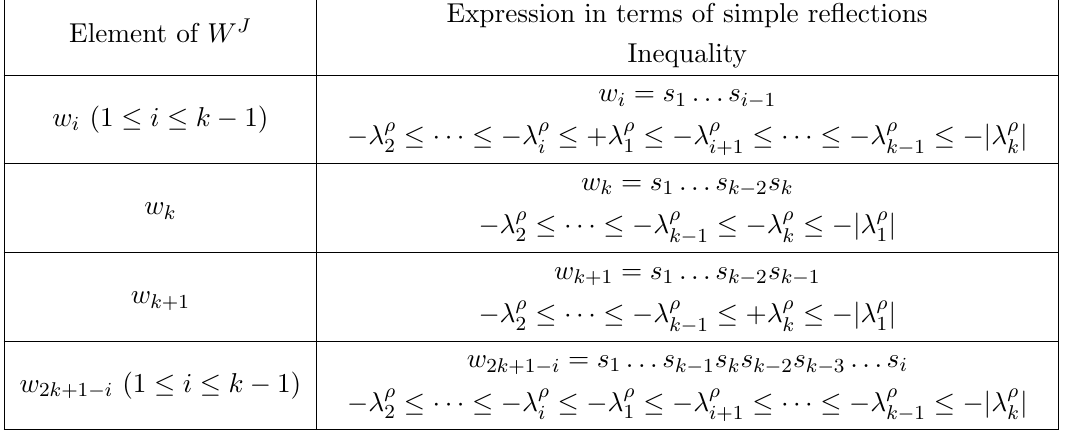
Table 7 . We write the inequality satis(cid:12)ed by a weight of the form (cid:21) = w (cid:14) ;J w j (cid:1) (cid:22) (cid:21) with (cid:22) (cid:21) antidom- inant. We recall that a weight (cid:21) in D k is antidominant if and only if (cid:21) (cid:26) w the inequalities that w (cid:1) (cid:22) (cid:21) satis(cid:12)es, with (cid:22) (cid:21) antidominant. This means that we select the lowest value of i such that (cid:21) satis(cid:12)es the inequality associated to the coset